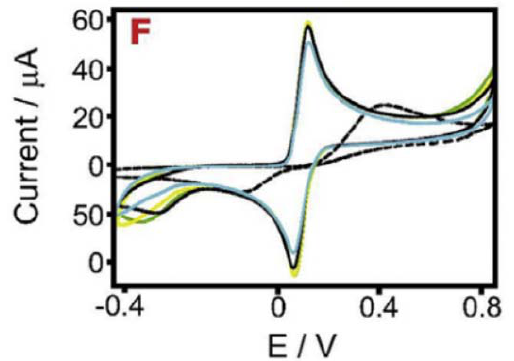
Figure 8. Cyclic voltammograms obtained in phosphate buffer 0.05 M ‐ KCl ‐ 0.1 M, pH 7.4, in presence of 2 mM of CA. All recorded at a scan rate of 50 mV ∙ s − 1 using bare SPEs (dashed line) and SPEs modified with HP 160 (green line), N115 (yellow line), N375 (black line), and PL6 (cyan line) [169].